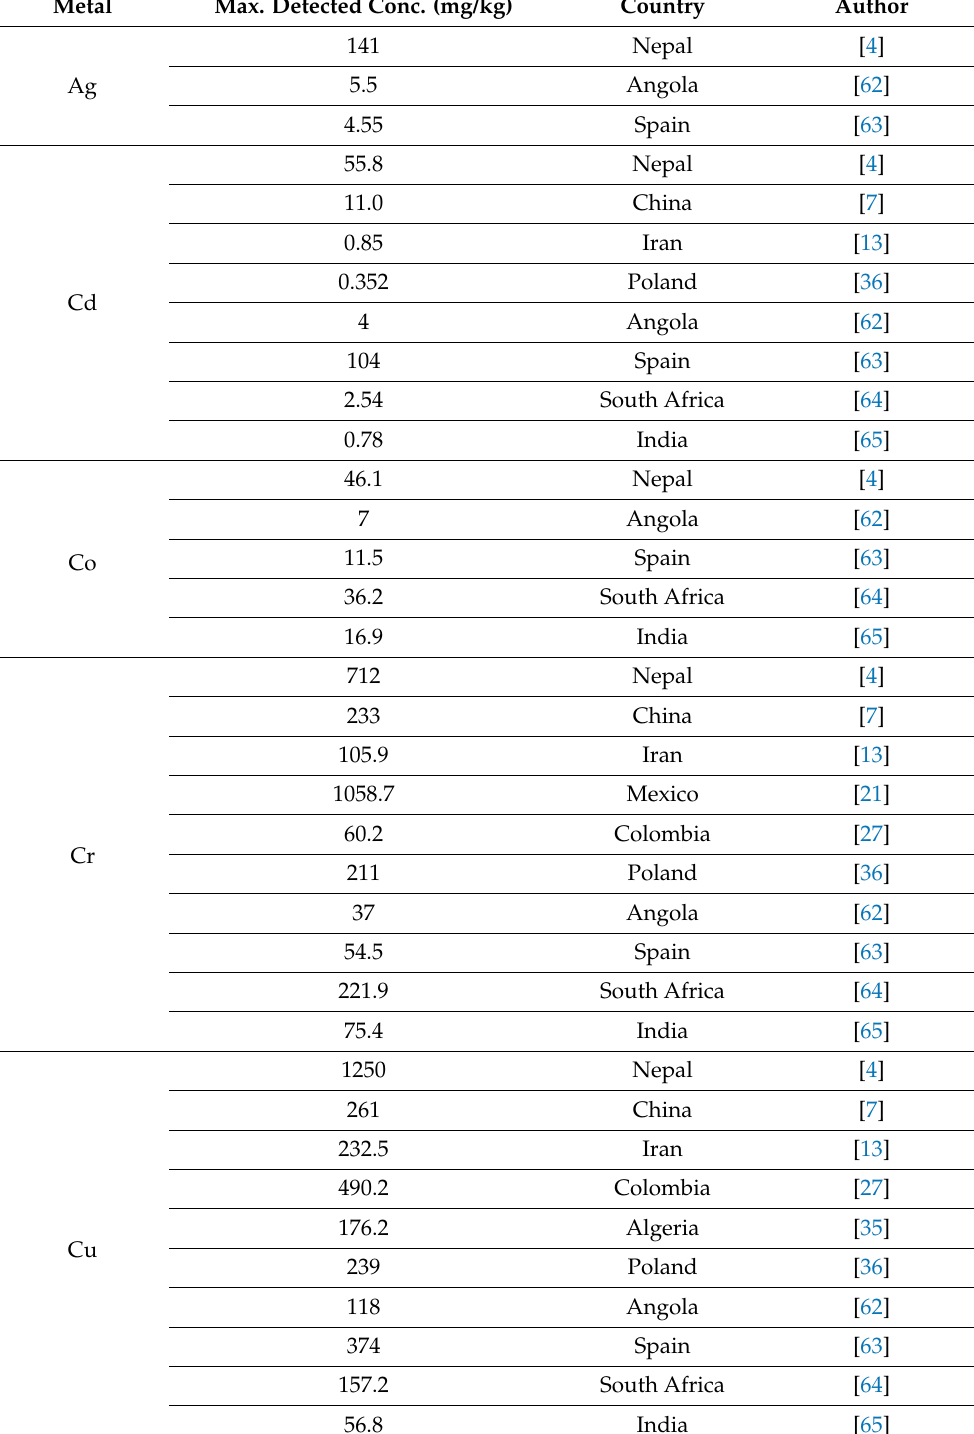
Table 2. Heavy-metal levels in urban dust of some parts of the